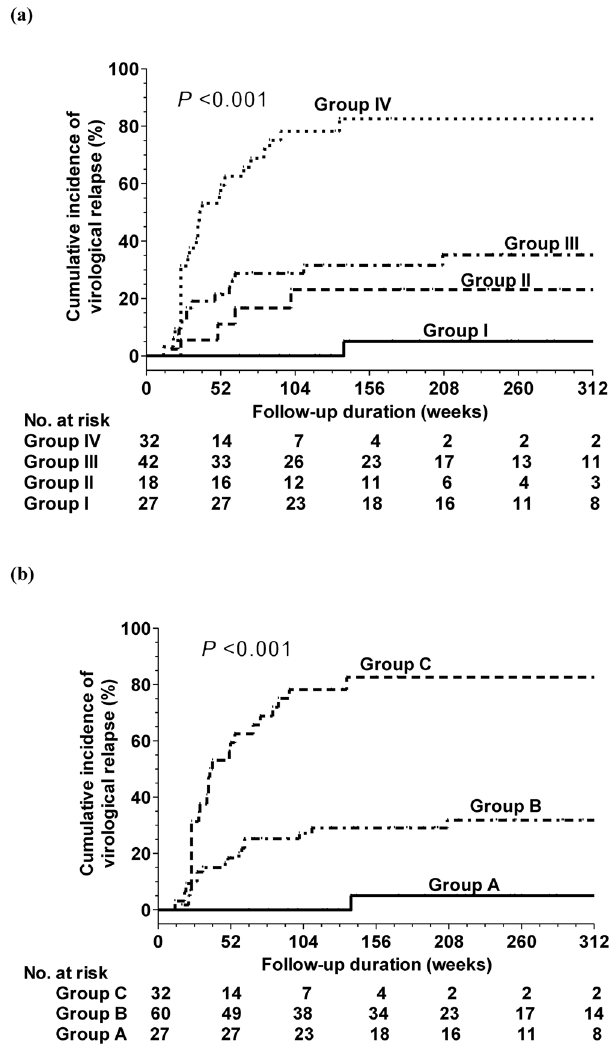
Figure 1. Cumulative incidence of virological relapse according to combining HBV DNA at entry and end- of-treatment HBsAg levels ( a ) Group I: patients with HBV DNA < 2 × 10 5 IU/mL and HBsAg < 50 IU/mL; Group II: patients with HBV DNA ≥ 2 × 10 5 IU/mL and HBsAg < 50 IU/mL; Group III: patients with HBV DNA < 2 × 10 5 IU/mL and HBsAg ≥ 50 IU/mL; and Group IV: patients with HBV DNA ≥ 2 × 10 5 IU/mL and HBsAg ≥ 50 IU/mL. ( b ) Group A: HBV DNA < 2 × 10 5 IU/mL and HBsAg < 50 IU/mL; Group B: patients with HBV DNA ≥ 2 × 10 5 IU/mL and HBsAg < 50 IU/mL or patients with HBV DNA < 2 × 10 5 IU/mL and HBsAg ≥ 50 IU/mL; and Group C: patients with HBV DNA ≥ 2 × 10 5 IU/mL and HBsAg ≥ 50